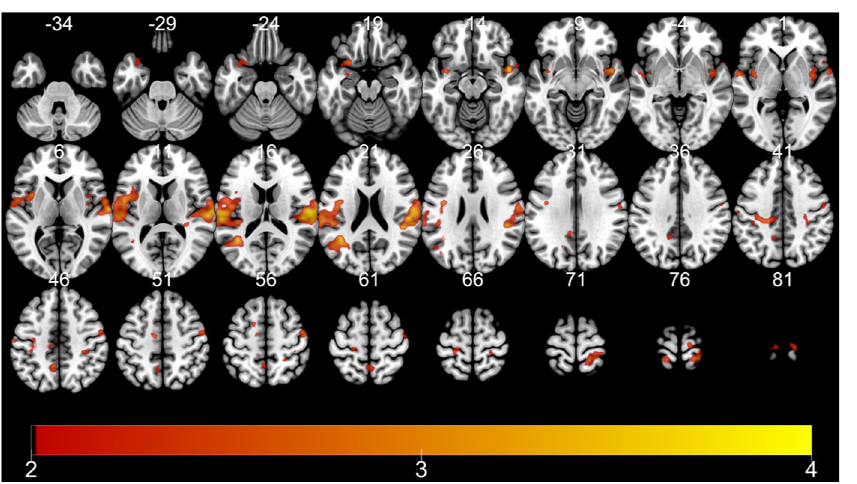
Fig 3. fMRI results (encoding): (1) Main effect of TD. Color bar indicates t-statistics.